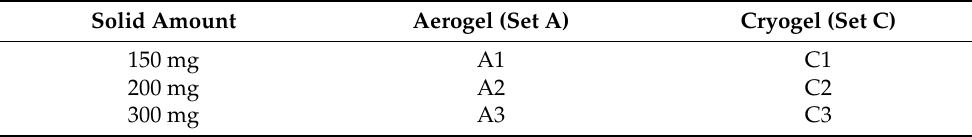
Table 2. Name abbreviations for all